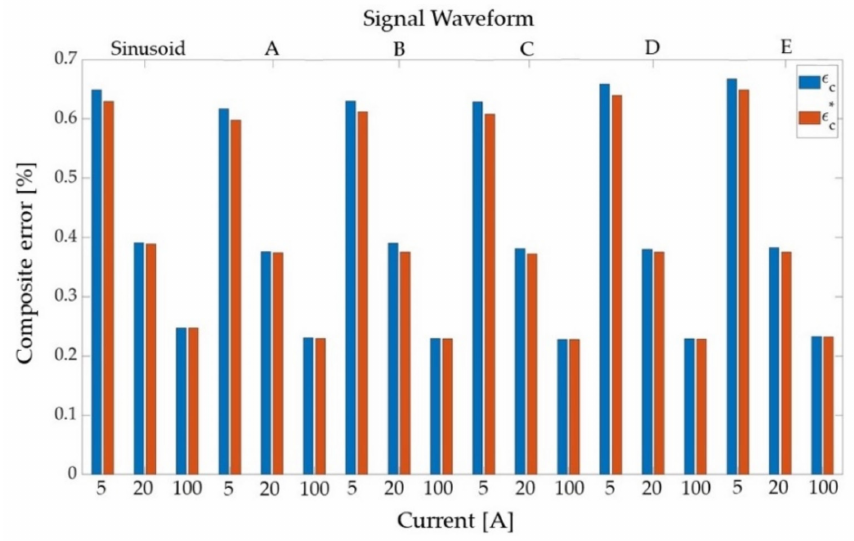
Figure 4. Graphical representation of the results in Table 7.